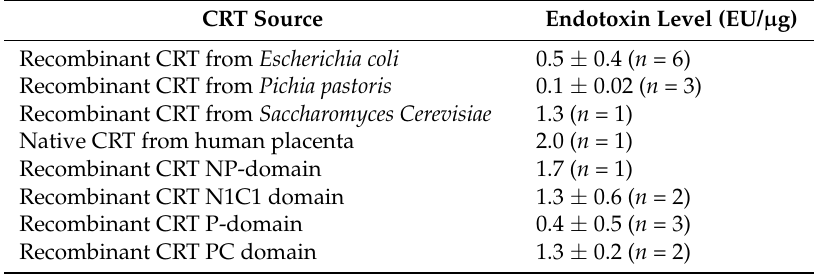
Table 1. Calreticulin (CRT) and CRT domains from multiple sources contain endotoxin (lipopolysaccharide, LPS).